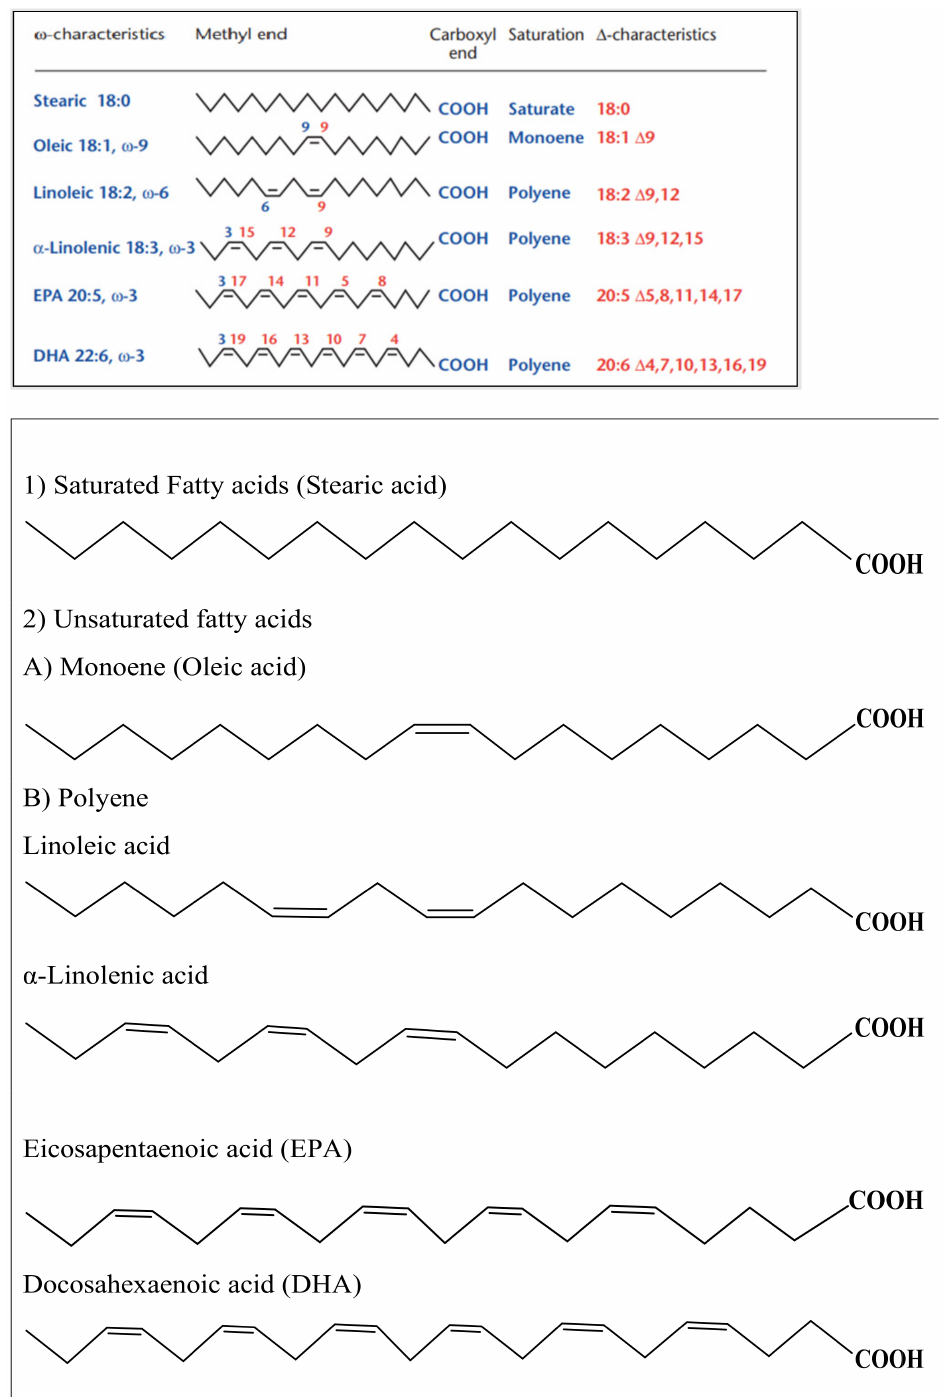
Figure 8. The structure of unbranched fatty acids, (1) Saturated and (2) Unsaturated, (A) monoene and (B)